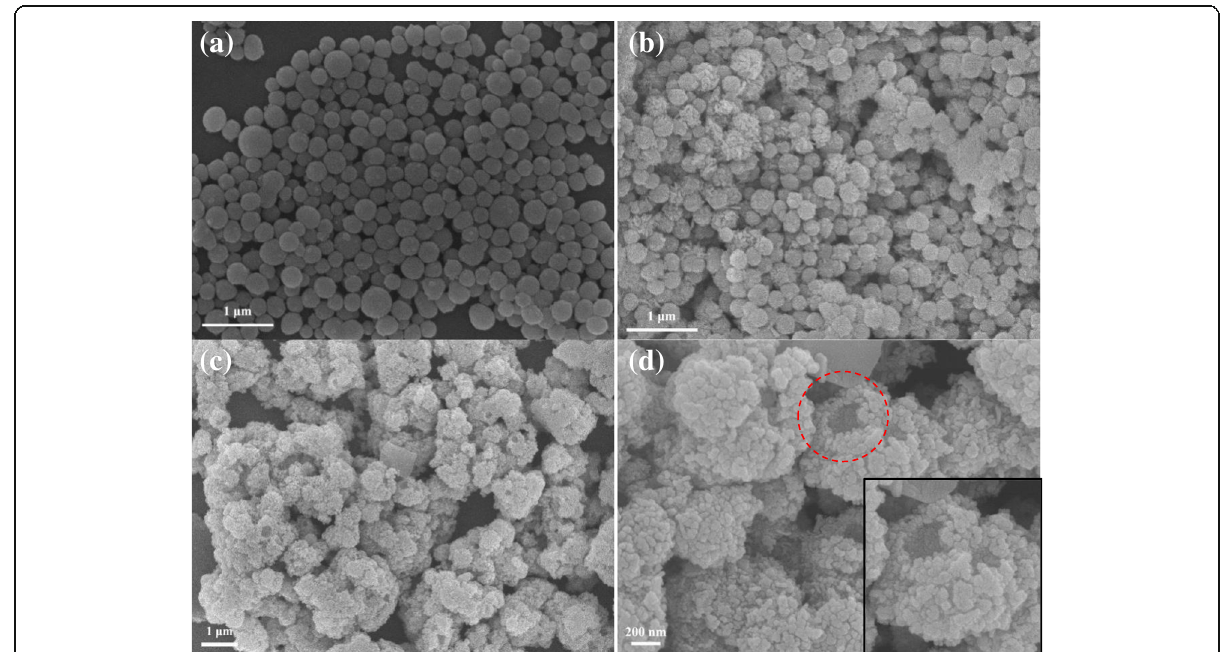
Fig. 2 SEM images of a TiO 2 (S)/CdTe, b TiO 2 (S)/CdTe/BiOI, and c – d TiO 2